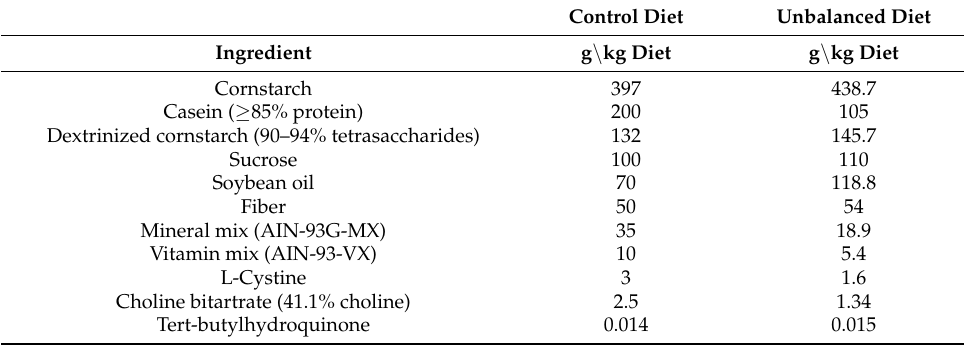
Table 1. Macronutrient, vitamin and mineral composition of the experimental diets. Values are presented as gram per dry weight.